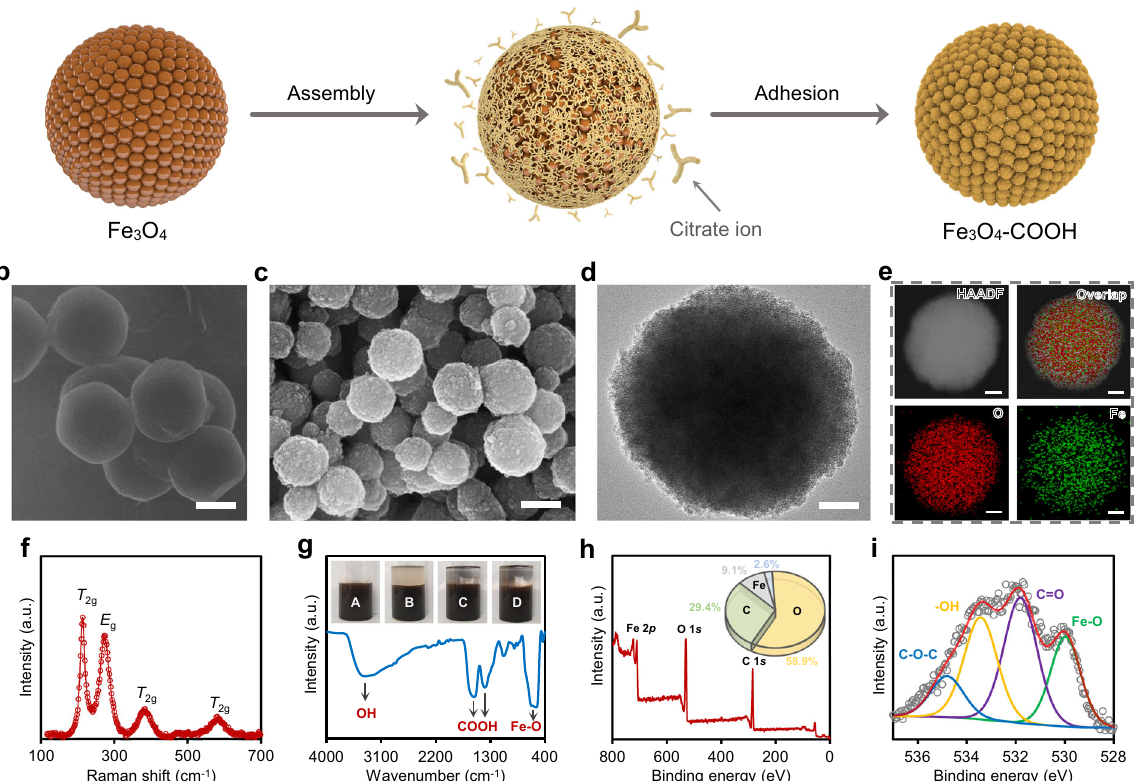
Fig. 2 Synthesis of the water-dispersible magnetic substrate with acidic characteristics. a Schematic of the formation of nanoclusters in a one-pot synthesis methodology. b HIM and c SEM images of the acidic Fe 3 O 4 – COOH substrate. Scale bars are 200 nm. d TEM image of a single Fe 3 O 4 – COOH nanocluster and its corresponding e HAADF and EDX mapping. Scale bars are 50 nm. f Raman and g FTIR spectra of Fe 3 O 4 – COOH structure. Insets in g are the images of Fe 3 O 4 – COOH dispersion in pure water ( a ), followed by adding silicon oil ( b ), toluene ( c ), and diethyl ether ( d ). Before taking the picture, the mixtures were completely shaken and incubated for 15 min and nanocatalyst concentration was kept constant at 0.1 wt%; the transparency of the nonaqueous phase indicates the hydrophilicity of Fe 3 O 4 – COOH nanoclusters and their accumulation in the aqueous phase. h Full survey and i high- resolution XPS spectra showing the chemical moieties on the exterior surface of Fe 3 O 4 – COOH